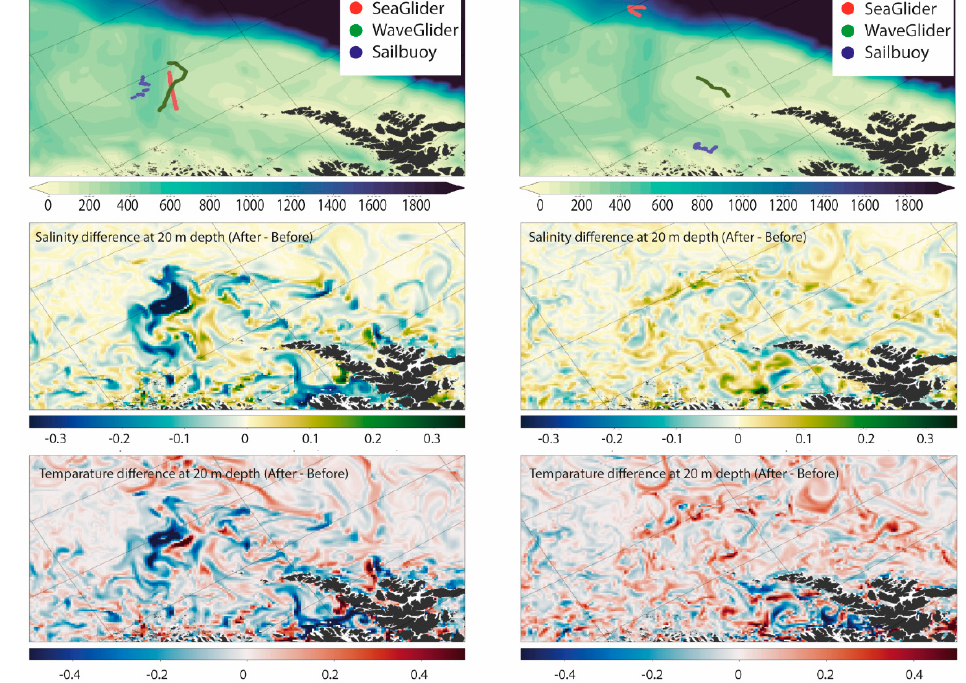
Figure 8. Snapshots (left column: 20 March 2018, right column: 3 April 2018) of glider data as- similation influence on the NorShelf-2.4km model salinity and temperature fields. Upper panel: topography and gliders’ positions, middle panel: salinity difference at 20 m depth, lower panel: temperature difference at 20 m depth [57] .